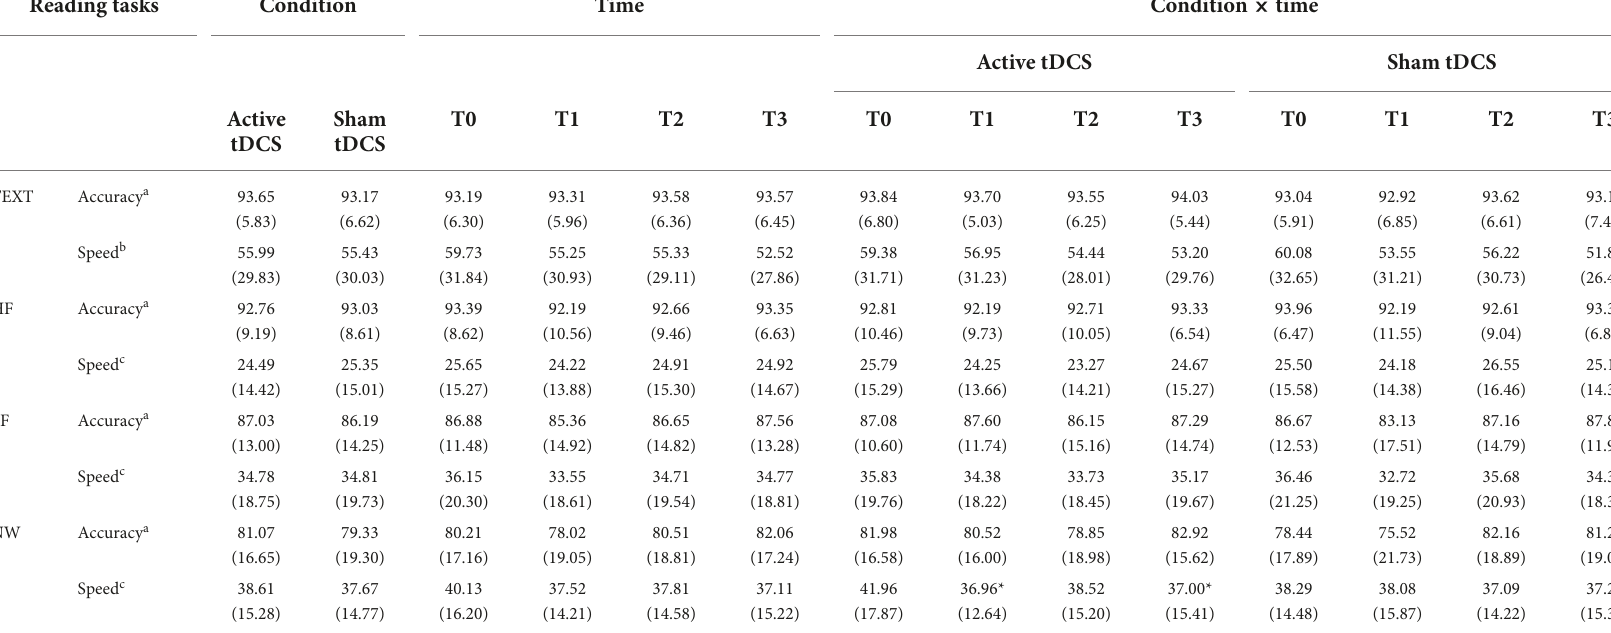
TABLE 2 Means (SDs) of the main effect of condition, time and of the condition × time interaction for TEXT, HF, LF, and NW measures for both accuracy and speed. Reading